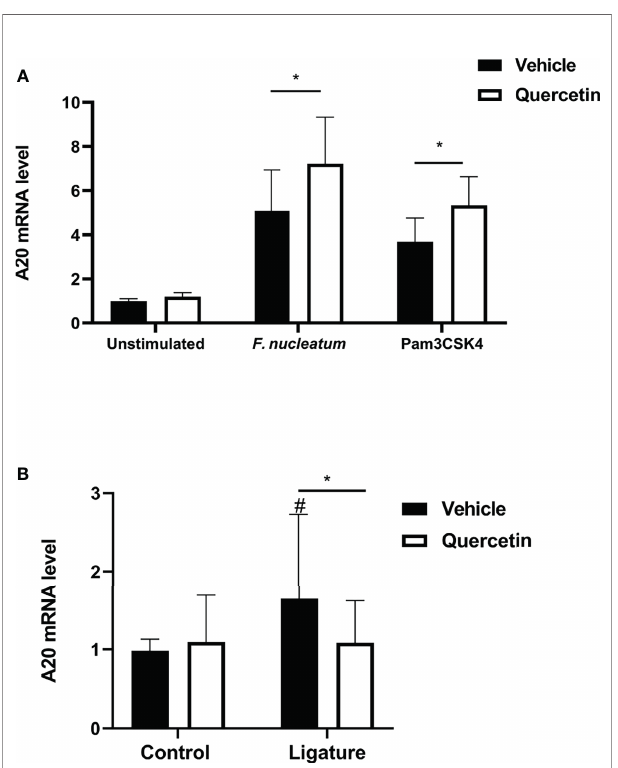
FIGURE 6 | Quercetin modulates A20 mRNA levels in pre-clinical periodontitis disease models. (A) THP-1 macrophages treated with Quercetin (5µg/mL) or vehicle matched control were infected with oral bacteria ( F.nucleatum [10 MOI]) or toll-like receptor agonist (Pam3CSK4 [10ng/mL]) for up to 6 hours and applied to RNA preparation. The mRNA levels of mA20 were determined with qRT-PCR and the relative mRNA expression levels were plotted. Each experiment was performed three times independently and averages and standard deviations are shown. *p ≤ 0.05. (B) Gingival tissues derived from ligated and control periodontium in Quercetin treated and vehicle treated mice were digested and applied to RNA preparation. The mRNA levels of mA20 were determined with qRT-PCR and the relative mRNA expression levels were plotted (n=11 for vehicle treatment, n=26 for Quercetin treatment). Averages and standard deviations are shown. *p ≤ 0.05. # Ligated gingival tissues versus corresponding experimental controls.